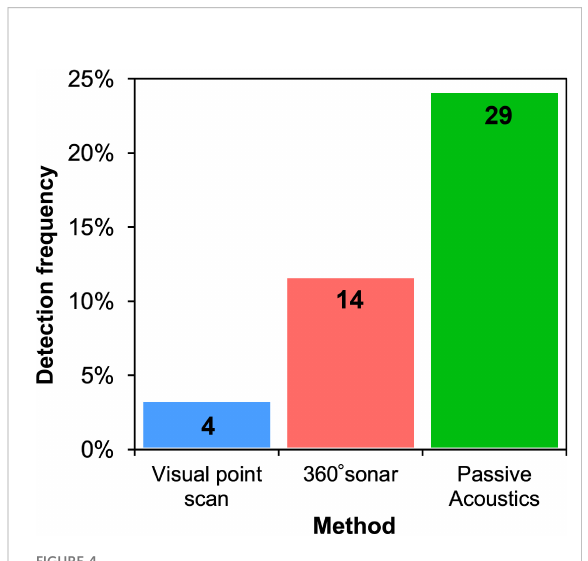
FIGURE 4 The number of manatee detections and detection frequency (%) across three survey methods (visual point scan, 360° sonar, and passive acoustics). Data are pooled across all ten sampling sites and include all 12 monthly samples (n= 120 surveys for each